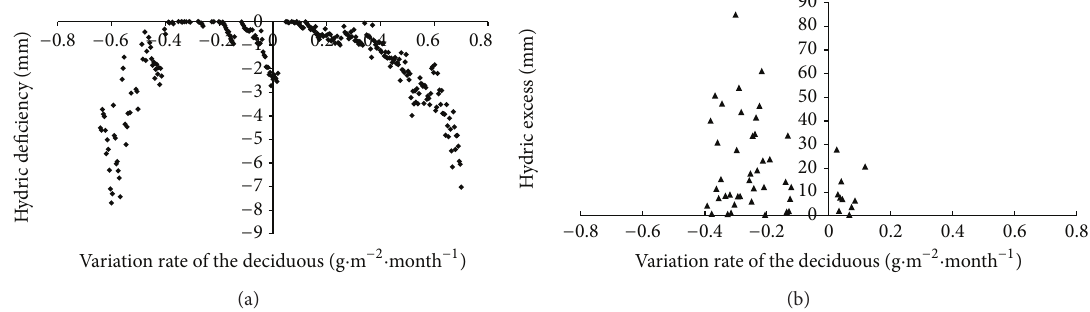
Figure 6: Relationship between the variation rate of the deciduousness with water deficiency and excess in Fragment 1.